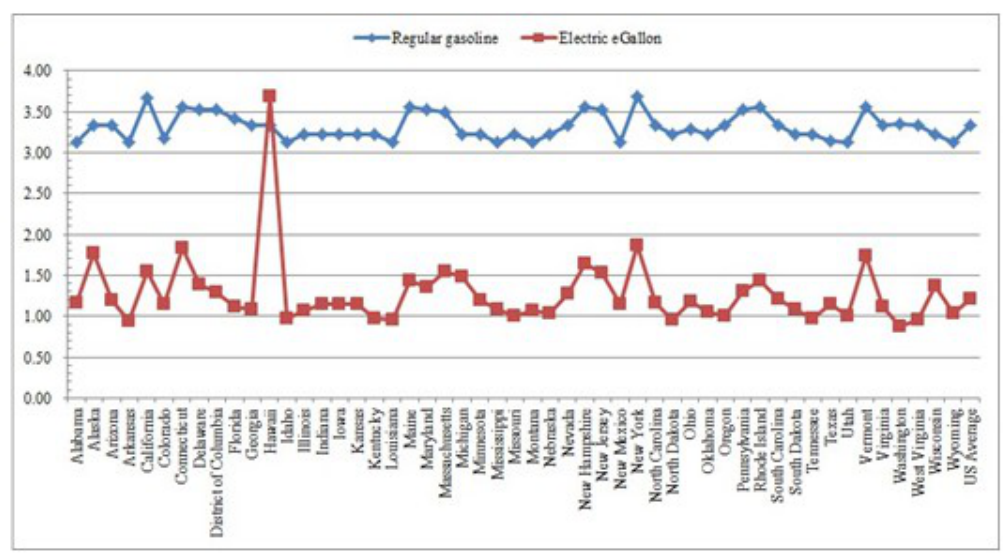
Figure 1. The unit prices of regular gasoline and electric eGallon in 50 states and 1 district in USA. Data was collected from the official website of US Department of Energy on March, 11, 2014